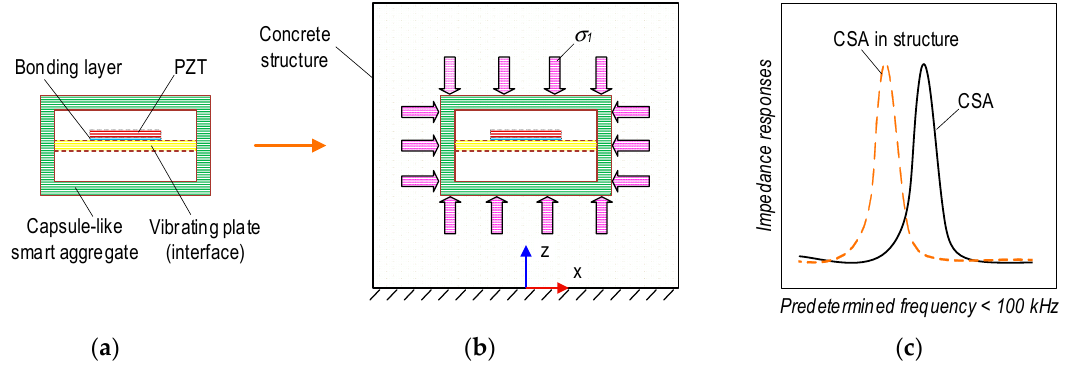
Figure 2. Behavior of CSA in concrete structure during concrete strength development. ( a ) CSA sensor. ( b ) CSA embedded in structure. ( c ) Impedance responses.